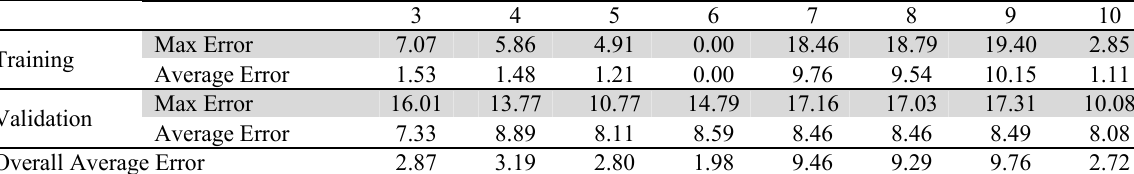
Maximum and average errors for Trial 2